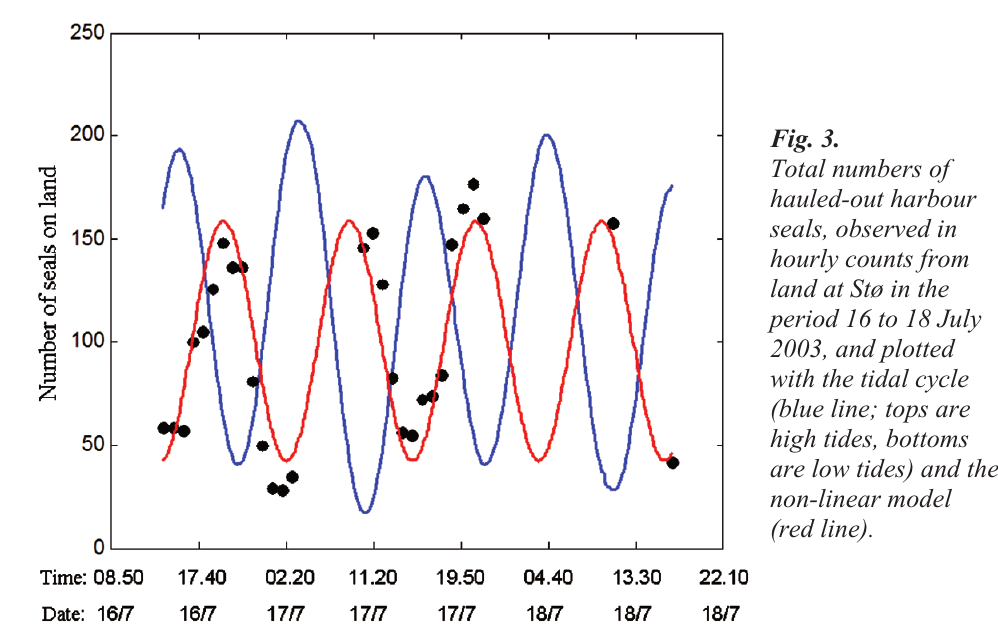
Fig. 3. Total numbers of hauled-out harbour seals, observed in hourly counts from land at Stø in the period 16 to 18 July 2003, and plotted with the tidal cycle (blue line; tops are high tides, bottoms are low tides) and the non-linear model (red